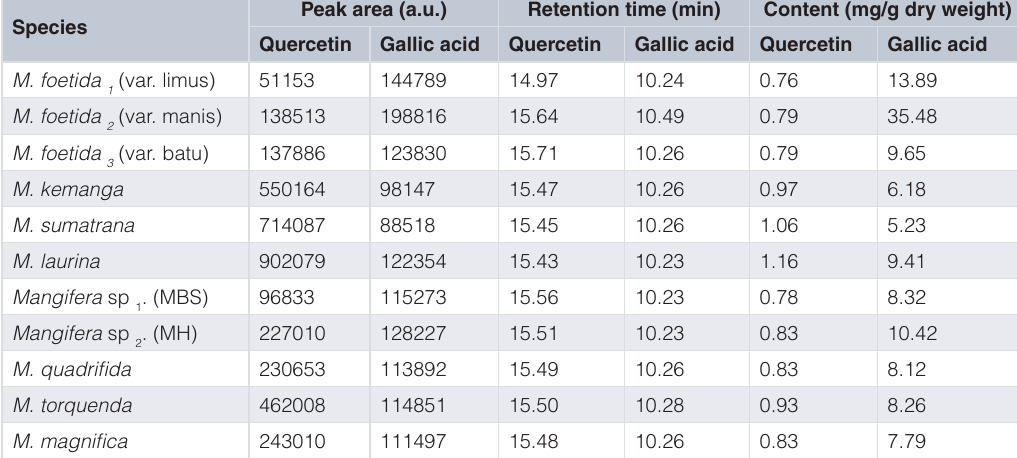
Table 3. Quercetin and gallic acid content of wild mango leaves from Sumatran, Indonesia. Peak area (a.u.) Retention time Species